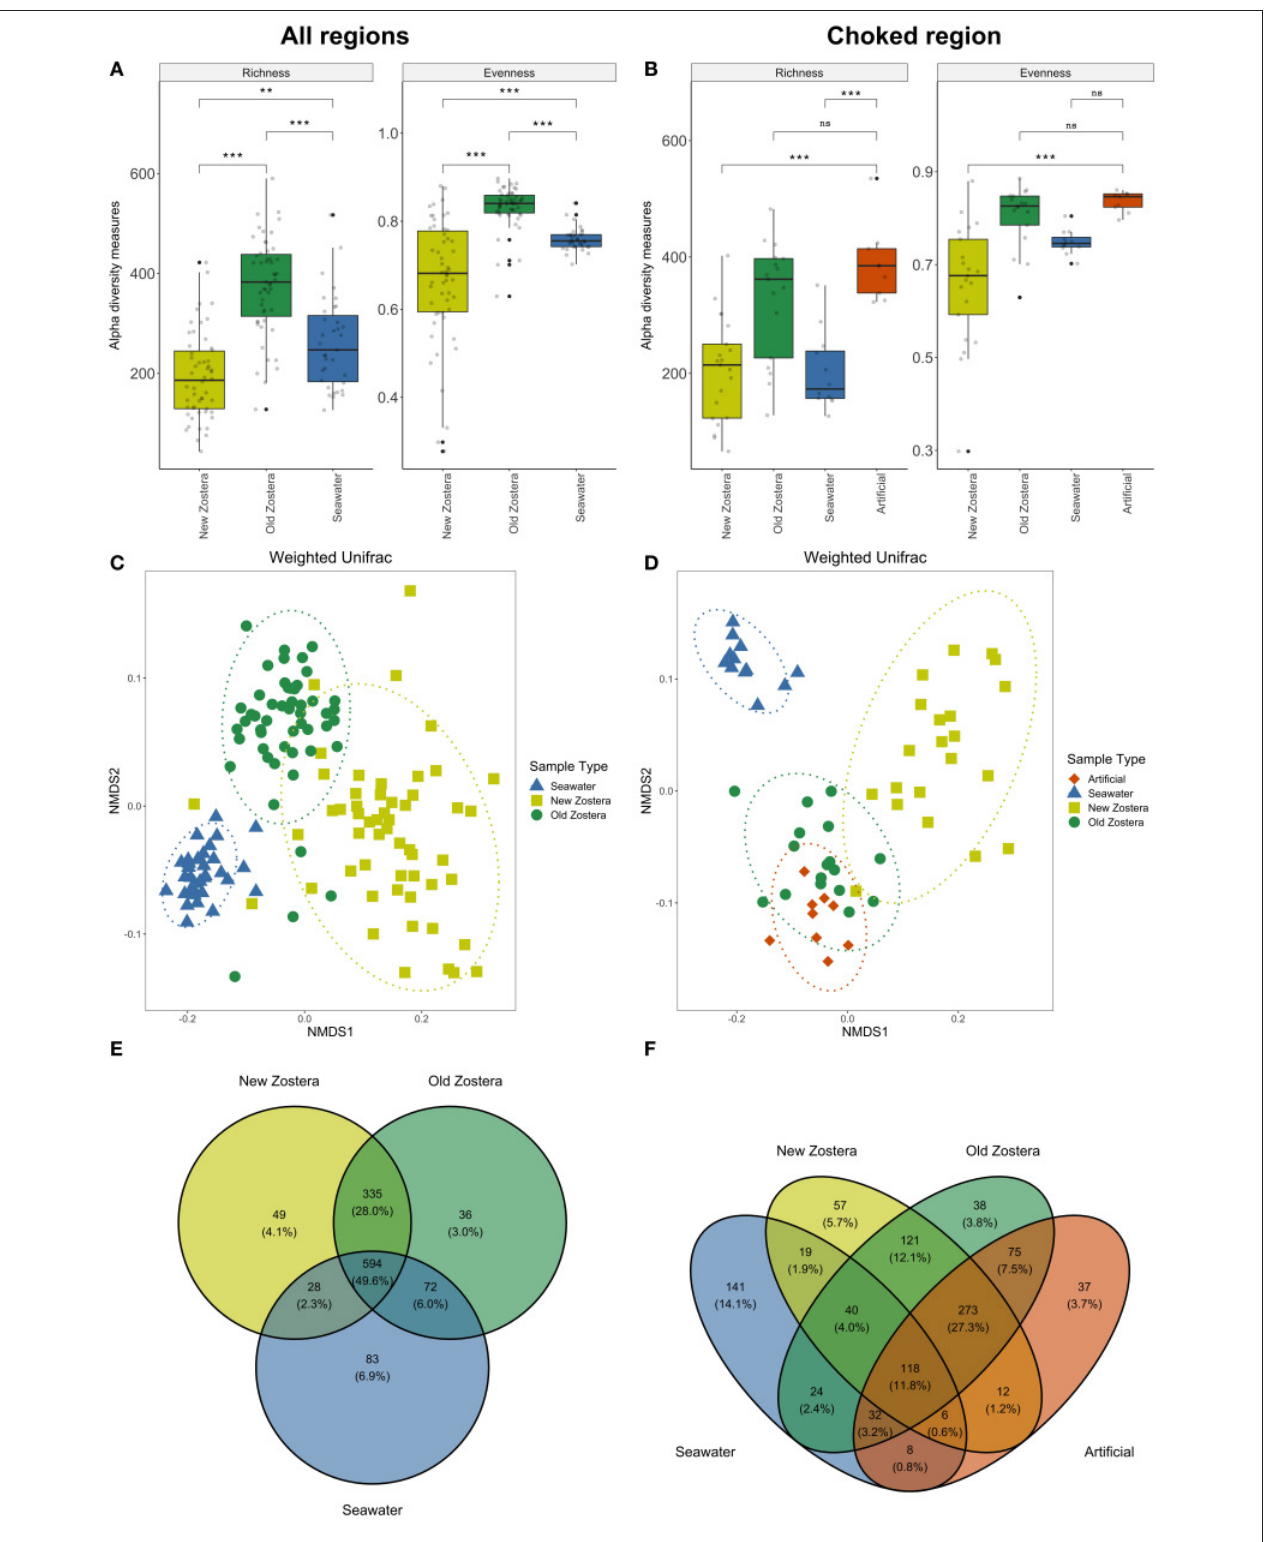
FIGURE 2 | Alpha diversity metrics, NMDS plots based on weighted UniFrac distances, and Venn diagrams of shared taxa of microbial communities on Z. marina new growth leaves, old growth leaves, and seawater for all regions (A,C,E) , and for Choked region including artificial seagrass (B,D,F) . Asterisks in boxplots represent significant difference, where *indicates p > 0.05, **indicates p > 0.01, and ***indicates p > 0.001; ns, not significant. Ellipses in NMDS plots represent ordination confidence intervals (95%).